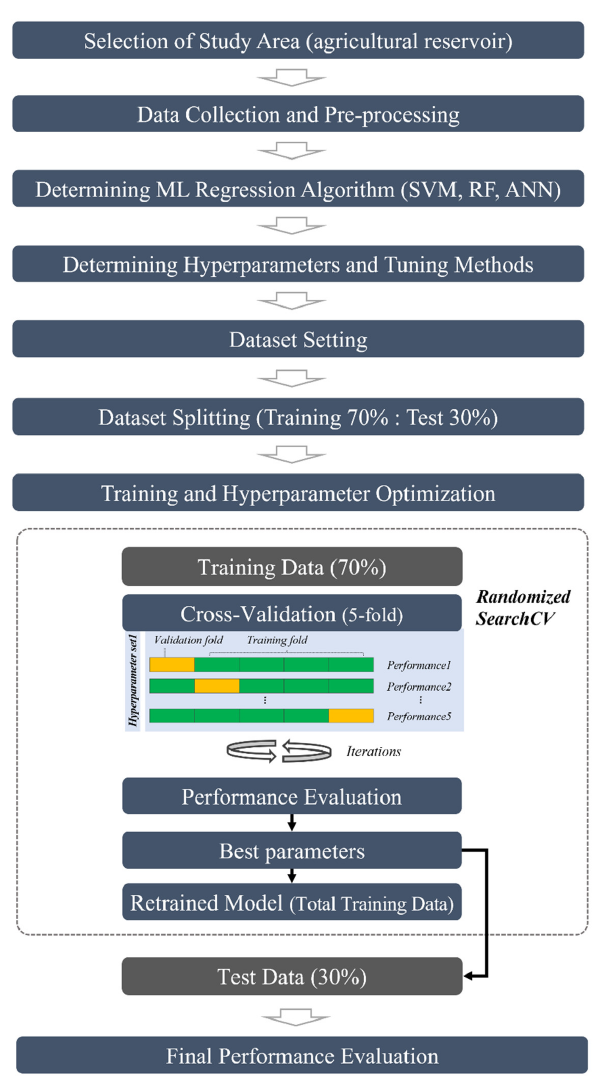
Figure 3. Flowchart of forecasting reservoir storage rates using machine learning